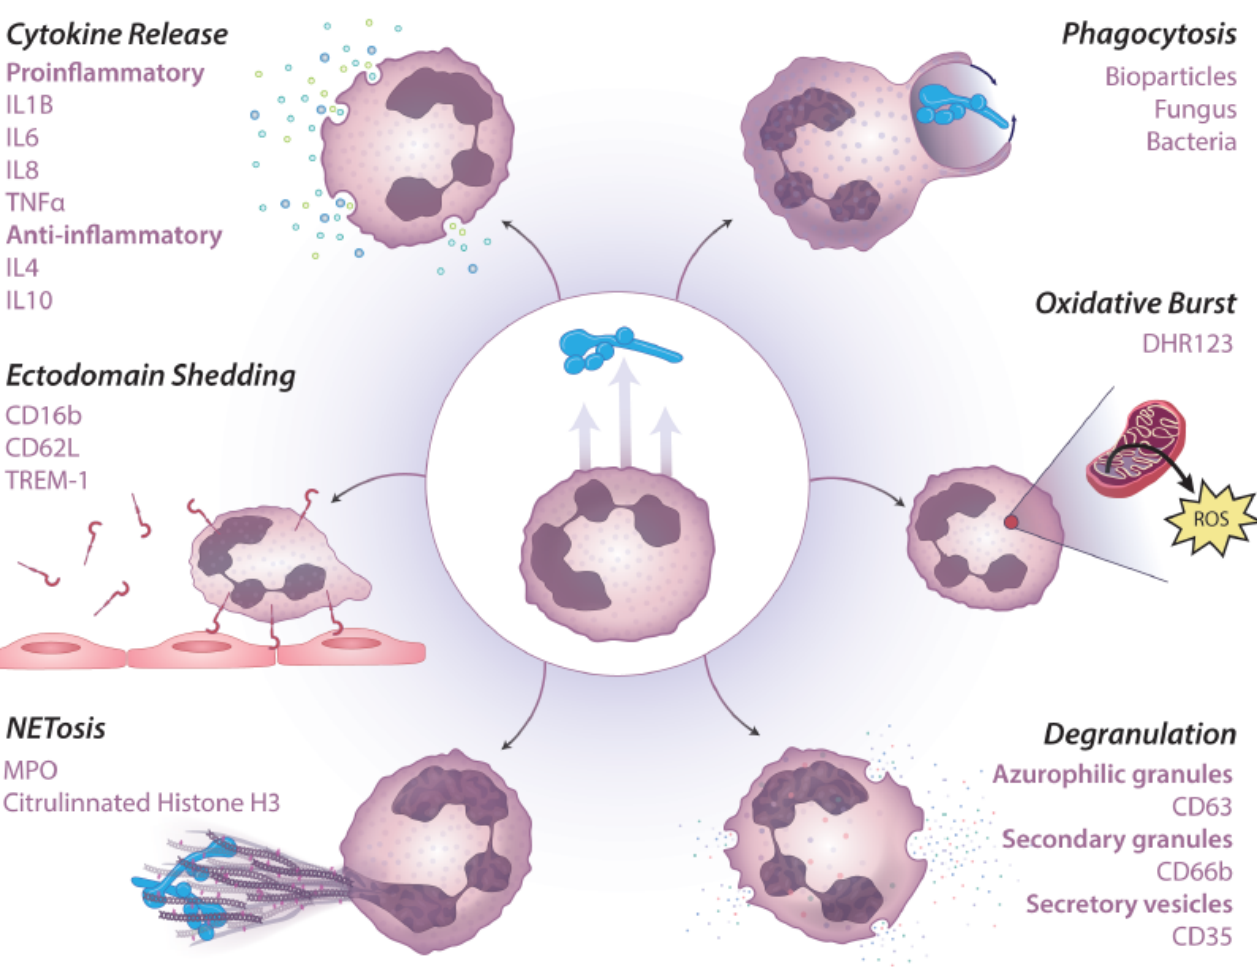
Figure 1. Measurable neutrophil functions by flow cytometry. Human neutrophils perform a variety of functions in response to pathogen sensing. Beneath each category or subcategory are surface proteins, soluble factors, dyes, or pathogenic insults that can be used to detect an array of neutrophil functions in a multiparametric flow cytometer-based assay. Illustration by Nicole Wolf, MS, ©2022. (nicolecwolf@gmail.com) Printed with permission.